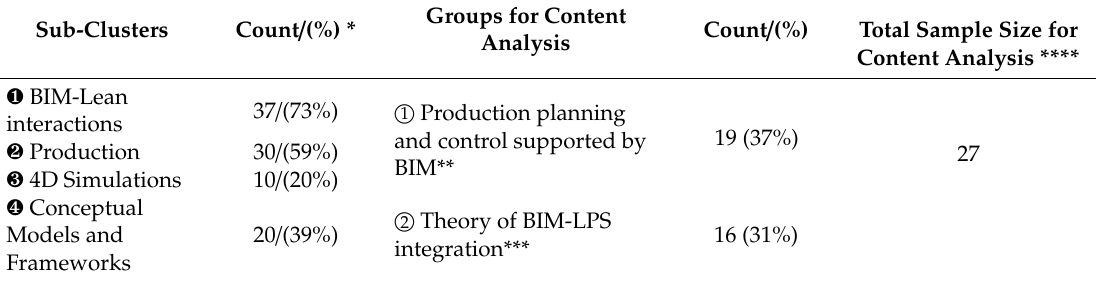
Table 7. Relevant sub-clusters and abstract groups for content